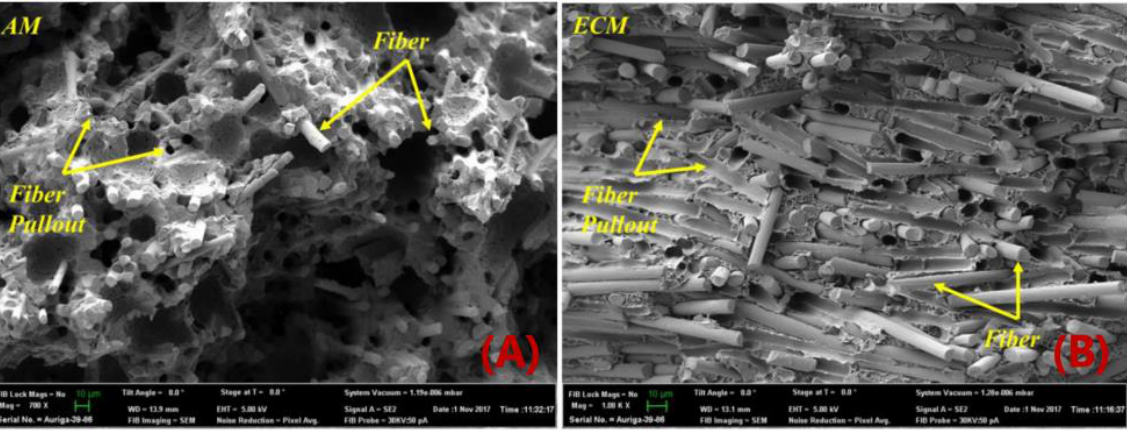
Figure 19. SEM micrographs of a fracture surface of tensile samples; ( A ) MEAM sample: Most of the fibers are aligned in printing direction, also contain voids; ( B ) Compression-molded sample: Fibers are well distributed in all directions [100].